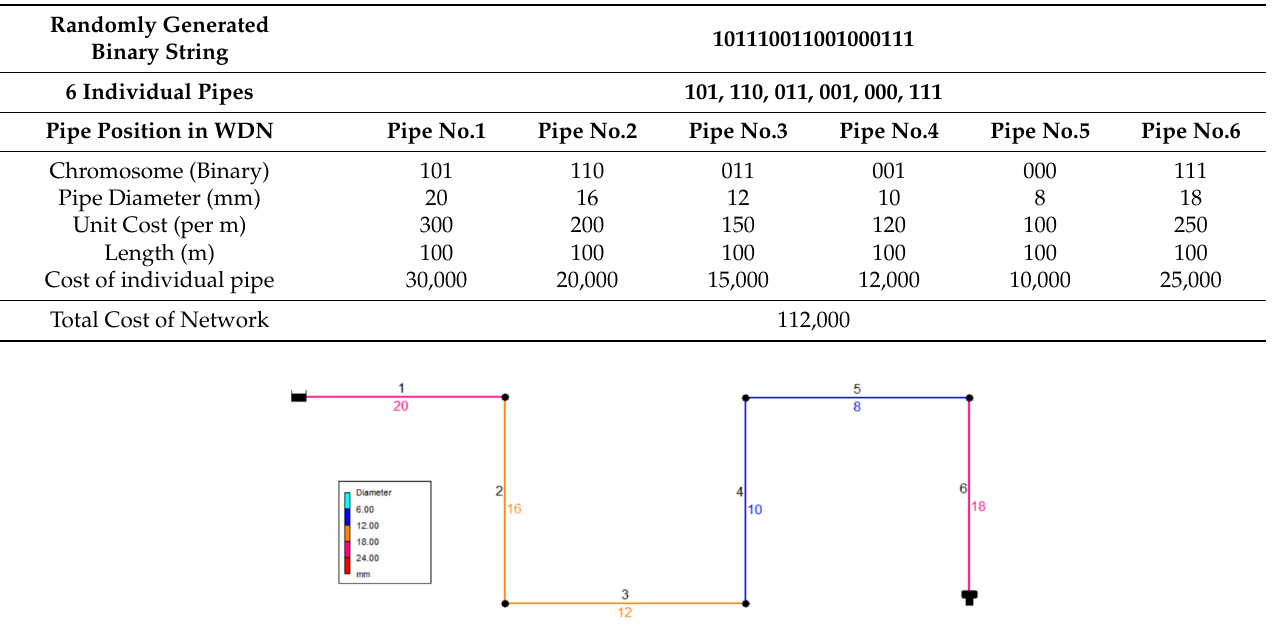
Table 2. Example: Interpretation of binary to pipe networks.